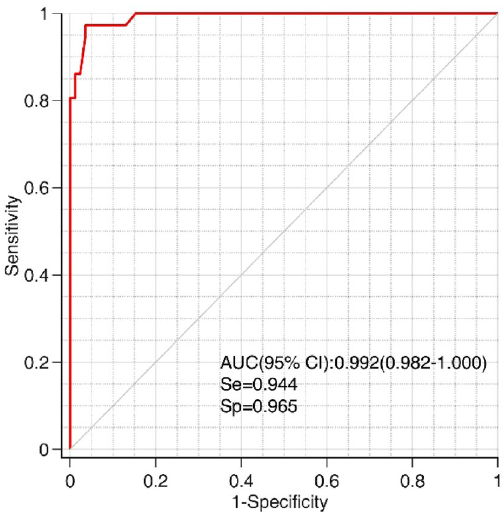
Figure 2. Receiver operating characteristic (ROC) curve of the quantitative diagnostic model for pelvic RMS in children using Fisher discriminant analysis.